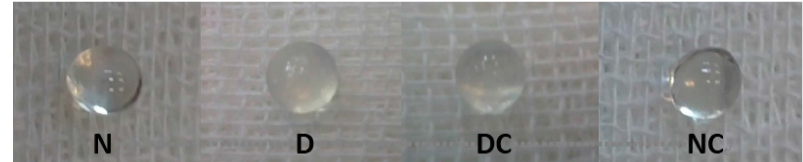
Figure 7. Change in the opacity of the lenses in different group of rats. N, Normal; D, diabetic; DC and NC, diabetic and normal rats received crocin(s).